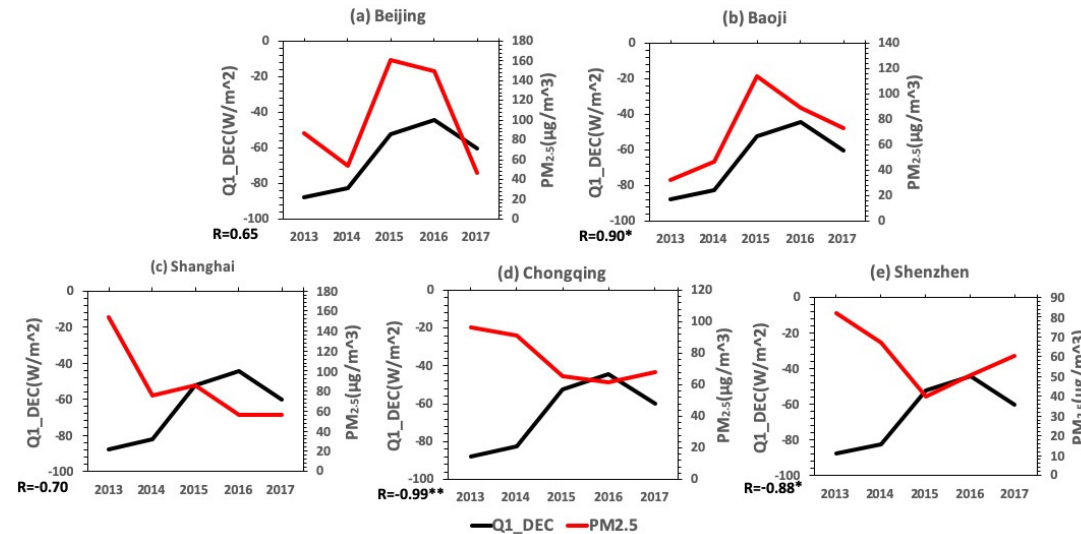
Figure 4. Correlation between the apparent heat source Q 1 of the Qinghai-Tibet plateau and PM 2.5 concentration of the representative cities of typical regions in China; (* means passing the single-tailed 95% confidence test, ** means passing the single-tailed 99% confidence test).